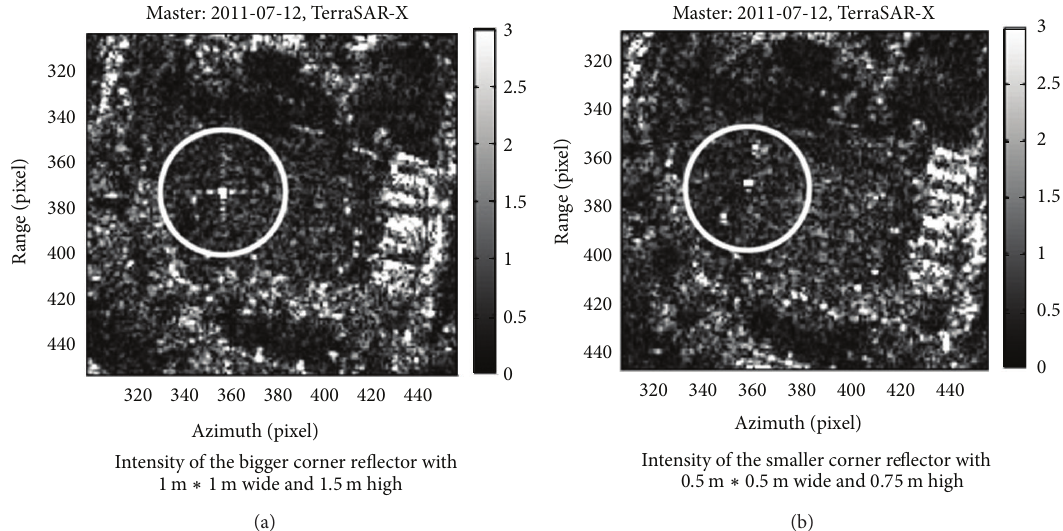
Figure 6: The intensity of two different sizes of reflectors with the same size of holes on the plate. The reflectors are deployed in a football pitch that has a very low noise background, and the signal of the reflector is evident.